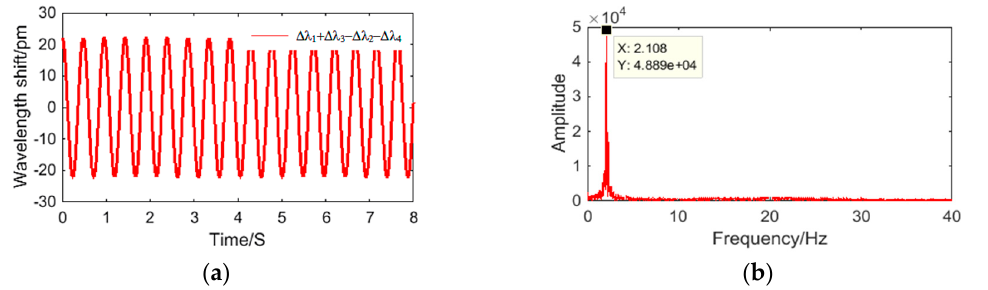
Figure 11. ( a ) Time domain and ( b ) spectrum map of ∆ λ 1 + ∆ λ 3 − ∆ λ 2 − ∆ λ 4 under the excitation with acceleration amplitude of 20 m/s 2 and frequency of 2 Hz. Sensors 2017 , 17 , x FOR PEER REVIEW 13 of 16